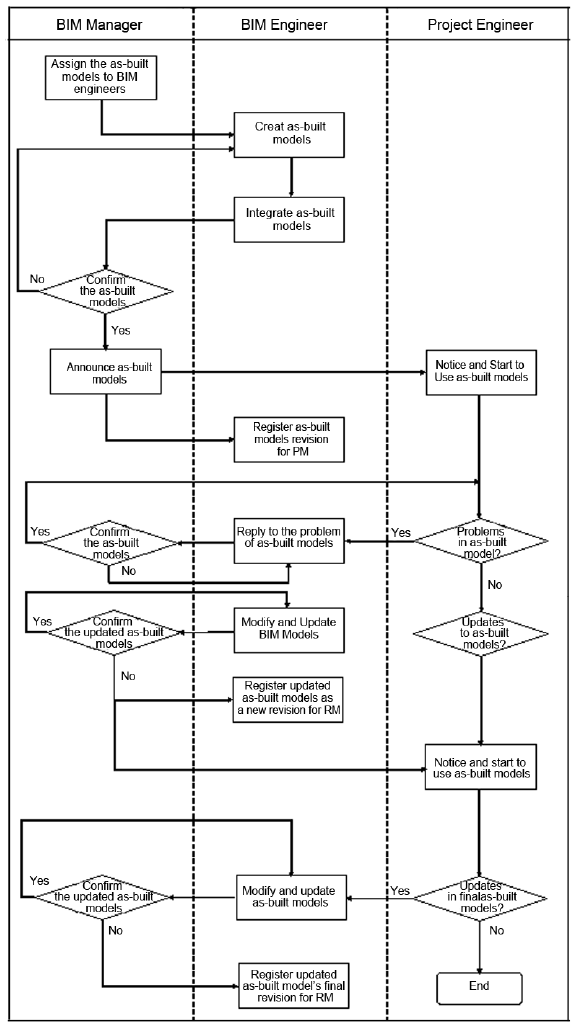
Fig. 5. The flowchart of the process used in the ConBIM-PM